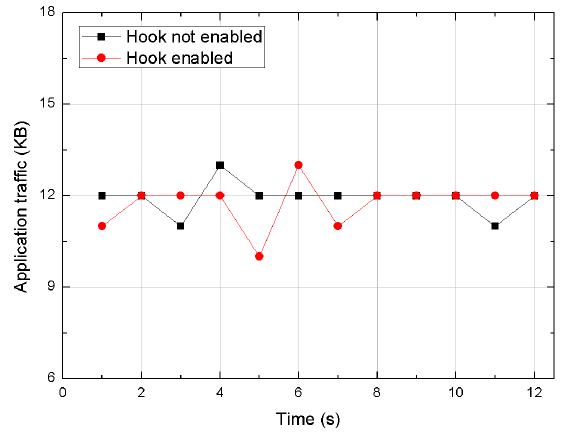
Figure 4. Tra ffi c comparison on WeChat application. Figure 4. Traffic comparison on WeChat application.